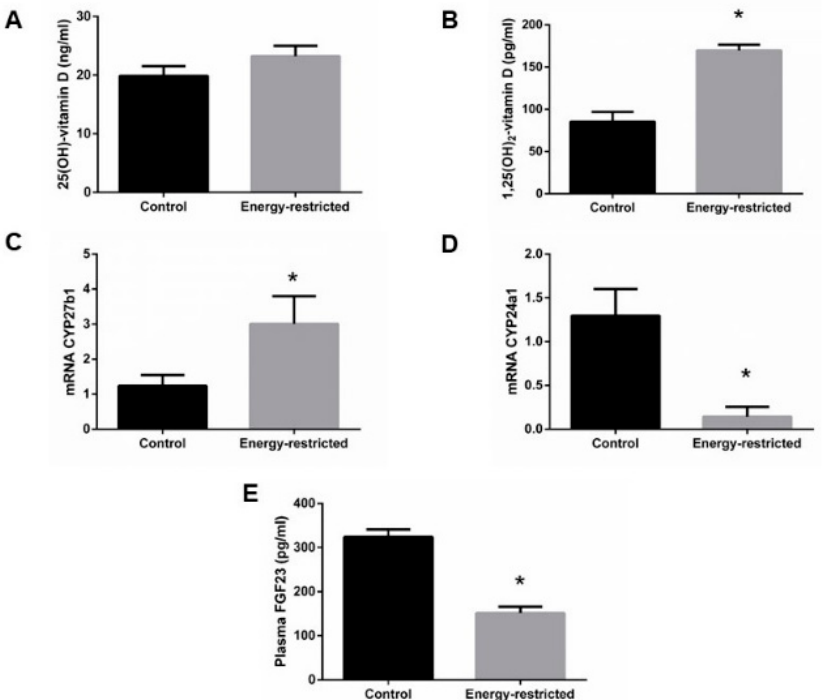
Figure 5. ( A ) Plasma concentrations of 25(OH)-vitamin D and ( B ) 1,25(OH) 2 -vitamin D, ( C ) kidney mRNA expression of the enzymes CYP27b1 and ( D ) CYP24a1 relative to GAPDH, and ( E ) plasma concentrations of fibroblast growth factor 23 (FGF23). Student’s t-test between control (black bars) and energy-restricted (grey bars) groups. * p < 0.05 vs. control.